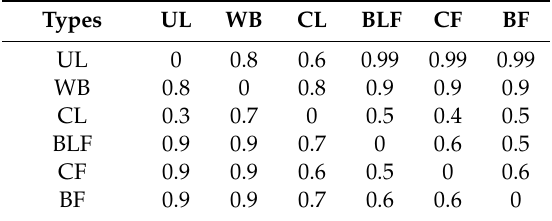
Table 4. The conversion cost of di ff erent land-use types from 2004 to 2049.